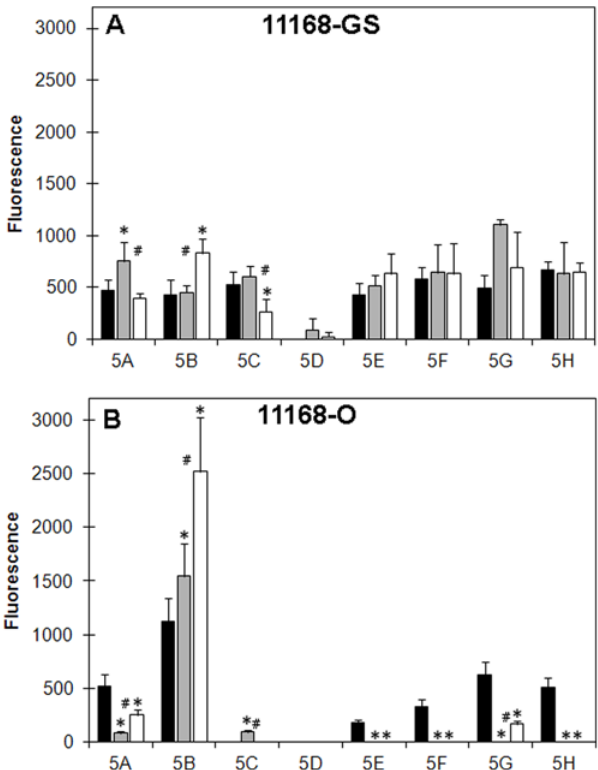
Figure 2. Binding of C. jejuni 11168 to Man containing structures. Fluorescence intensities associated with C. jejuni 11168- GS (A) and C. jejuni 11168-O (B) binding to Man containing glycans (25 u C, black bar; 37 u C, grey bar; and 42 u C, white bar). For the structure of the individual glycans refer to Table 2. * Significantly different to 25 u C, P , 0.05; # Significant difference between 37 u C and 42 u C, P , 0.05.